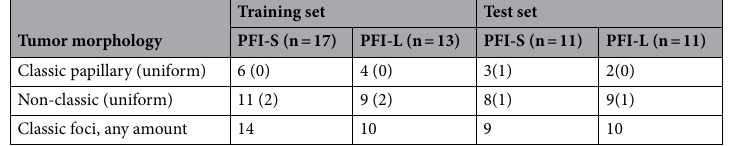
Table 2. Morphologic classification of the training and testing